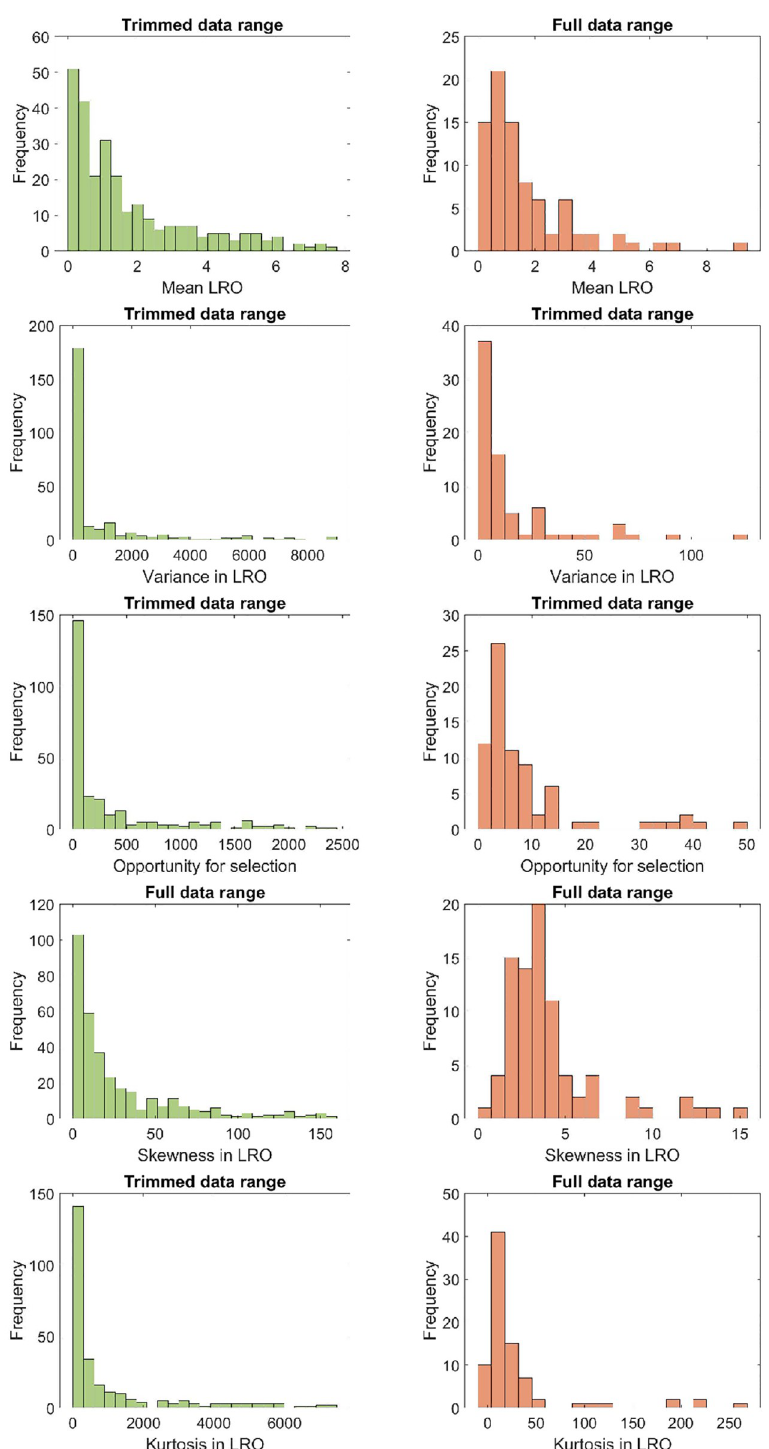
Fig 1. Histograms of the statistics of LRO (mean, variance, OFS, skewness, and kurtosis) for 332 populations of plants (left hand figures), and for 83 populations of animals (right hand figures). For both, some distributions were trimmed to better show the shape of the distribution; where the top of the plot reads “Trimmed data range” we left out 20% of the values for animal and plant populations (highest and lowest 10%).